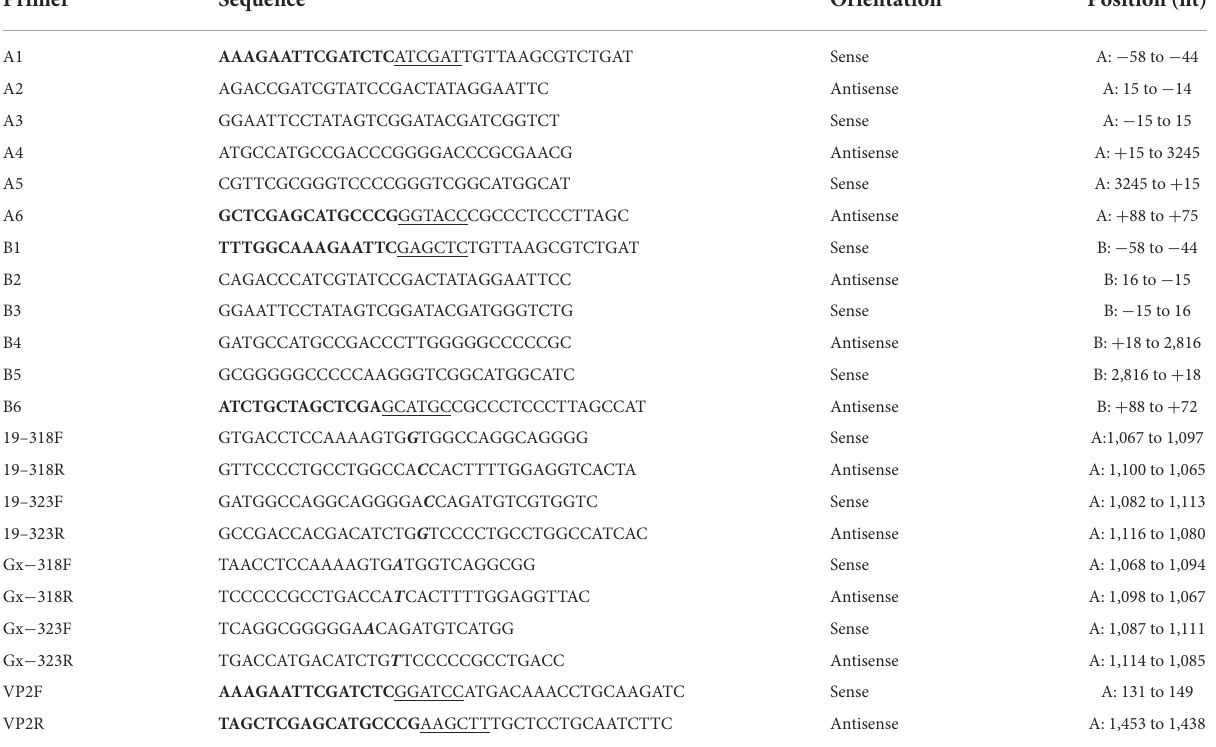
TABLE 1 Primers. Primer